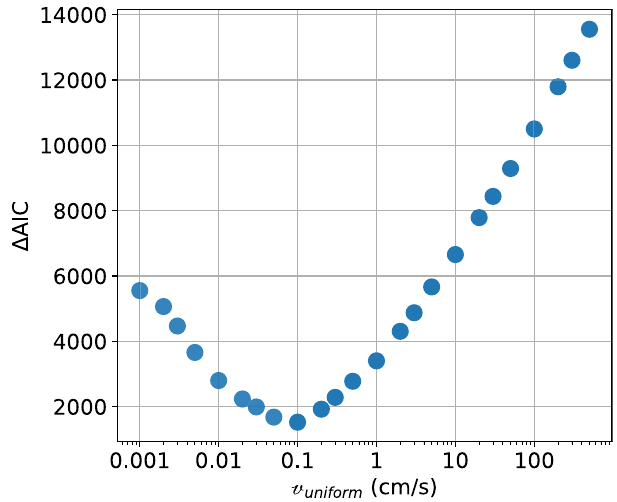
Fig. 5 | Δ AIC values as a function of v uniform , for a fl at velocity pro fi le with v ð f Þ = v uniform . The minimum Δ AIC corresponds toa solutionthatdoes not fi t Juno Doppler data: such a model does not represent adequately Juno ’ s